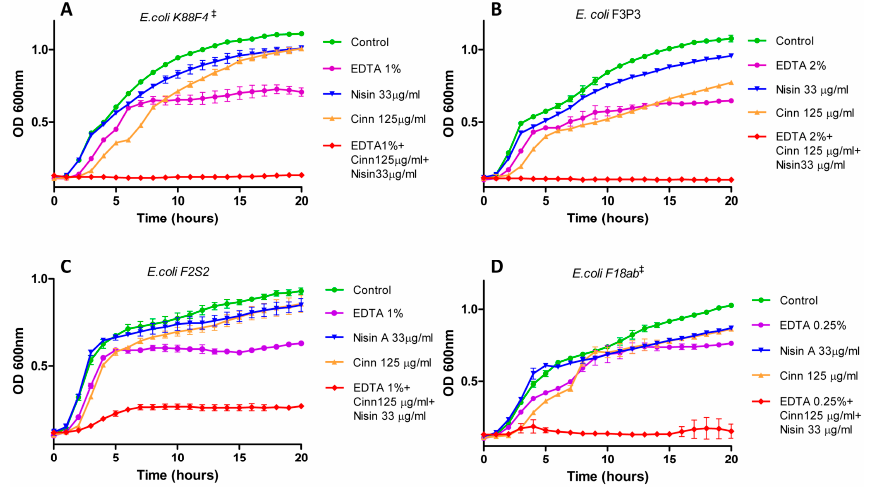
Figure 1. Growth curve analysis of ( A ) E. coli K88F4 in the presence of 1/6× minimum inhibitory concentration (MIC; 33 μ g/mL) nisin A (blue inverted triangle), 1/10× MIC (125 μ g/mL) cinnamaldehyde (orange triangle), ethylenediaminetetraacetic acid (EDTA) 1.0% (purple circle) in combination (red diamond) and untreated control (green circle), ( B ) E. coli F3P3 in the presence of 1/6× MIC (33 μ g/mL) nisin A (blue inverted triangle), 1/10× MIC (125 μ g/mL) cinnamaldehyde (orange triangle), EDTA 2% (purple circle), in combination (red diamond) and untreated control (green circle), ( C ) E. coli F2S2 in the presence of 1/6× MIC (33 μ g/mL) nisin A (blue inverted triangle), 1/10× MIC (125 μ g/mL) cinnamaldehyde (orange triangle), EDTA 1% (purple circle), in combination (red diamond) and untreated control (green circle) and ( D ) E. coli F18ab in the presence of 1/6× MIC (33 μ g/mL) nisin A (blue inverted triangle), 1/10× MIC (125 μ g/mL) cinnamaldehyde (orange triangle), EDTA 0.25% (purple circle), in combination (red diamond) and untreated control (green circle). ‡ denotes ETEC strains.